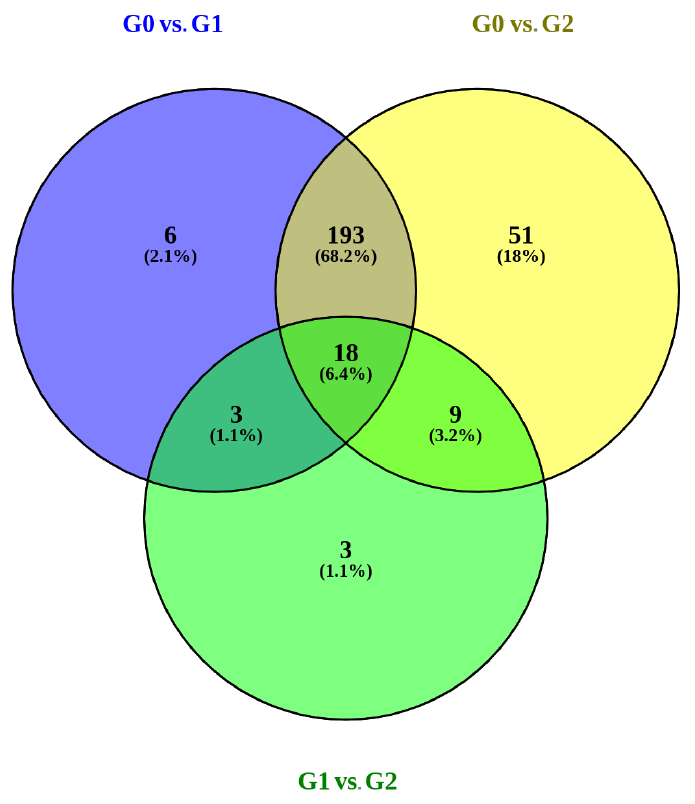
Figure 2. Venn diagram showing DE miRNA in the three differential expression analyses performed in TCGA. Intersections represent those miRNAs commonly differentially expressed.